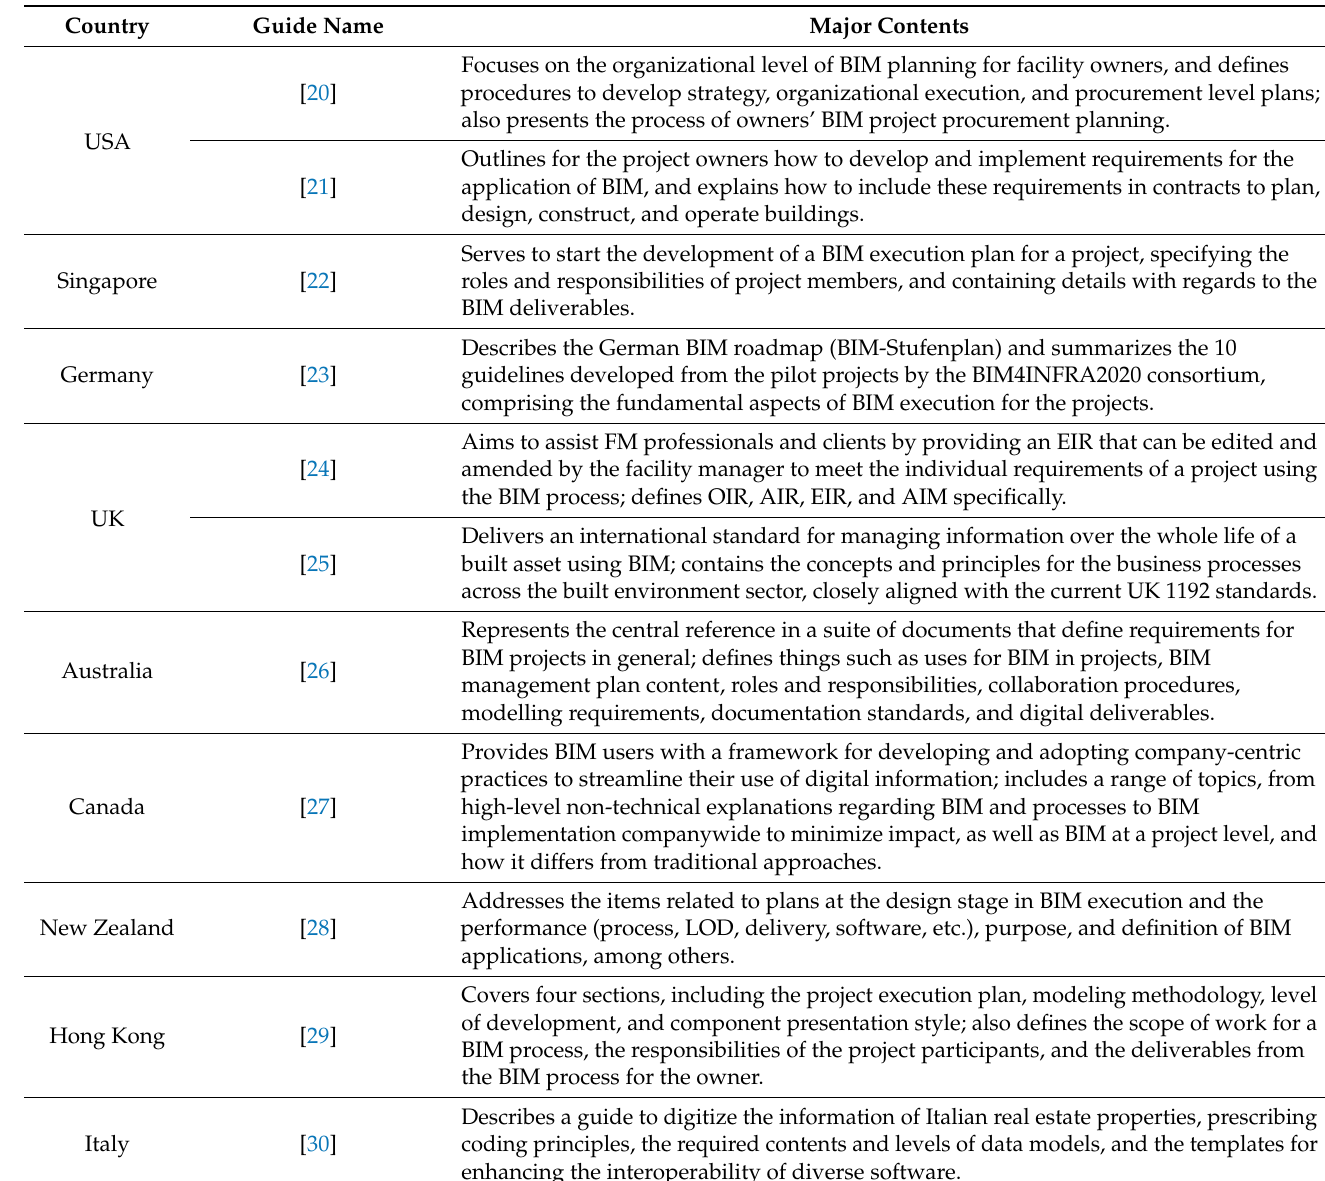
Table 2. International BIM guides